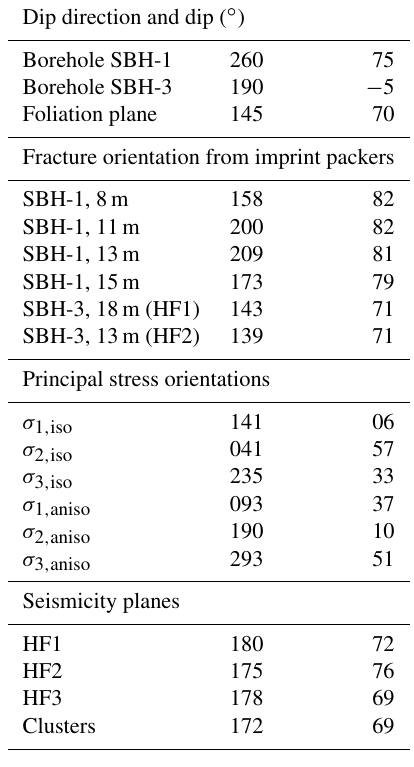
Table 1. Orientations of boreholes, fractures at the borehole wall, seismicity clouds and principal stress